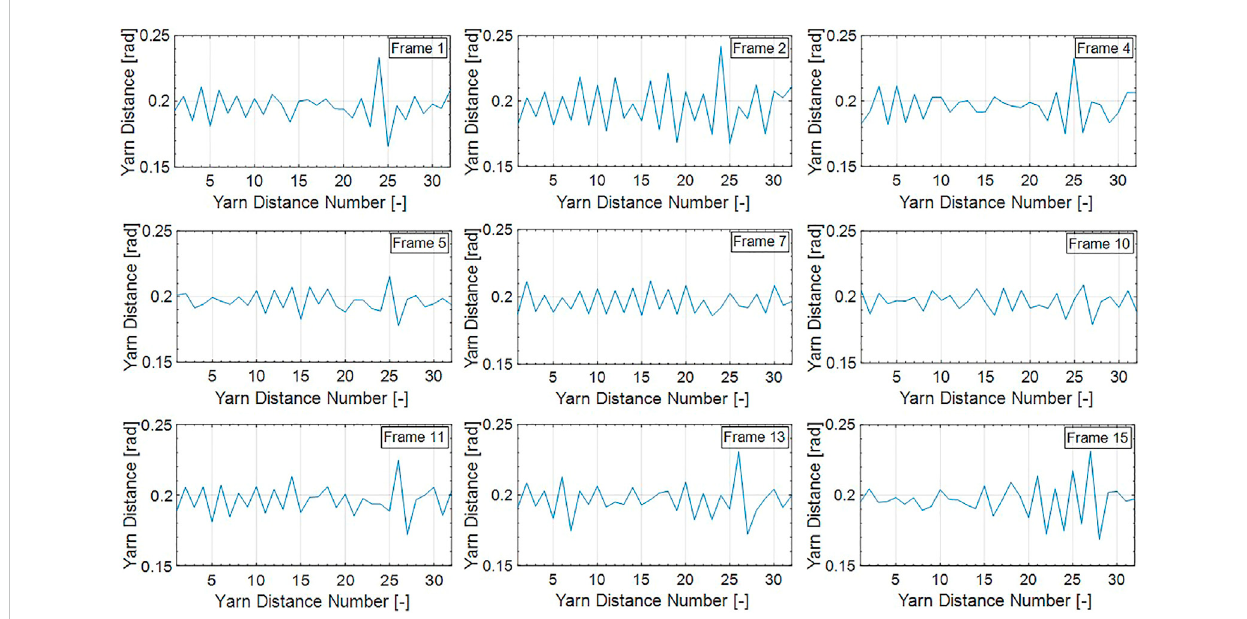
FIGURE 6 Yarn distance measurement results of counterclockwise yarns of the fi rst 15 frames of the braiding experiment with n yarn (cid:1) 64 12 k yarns and an elevated tension of a single counterclockwise yarn of ~35 N.